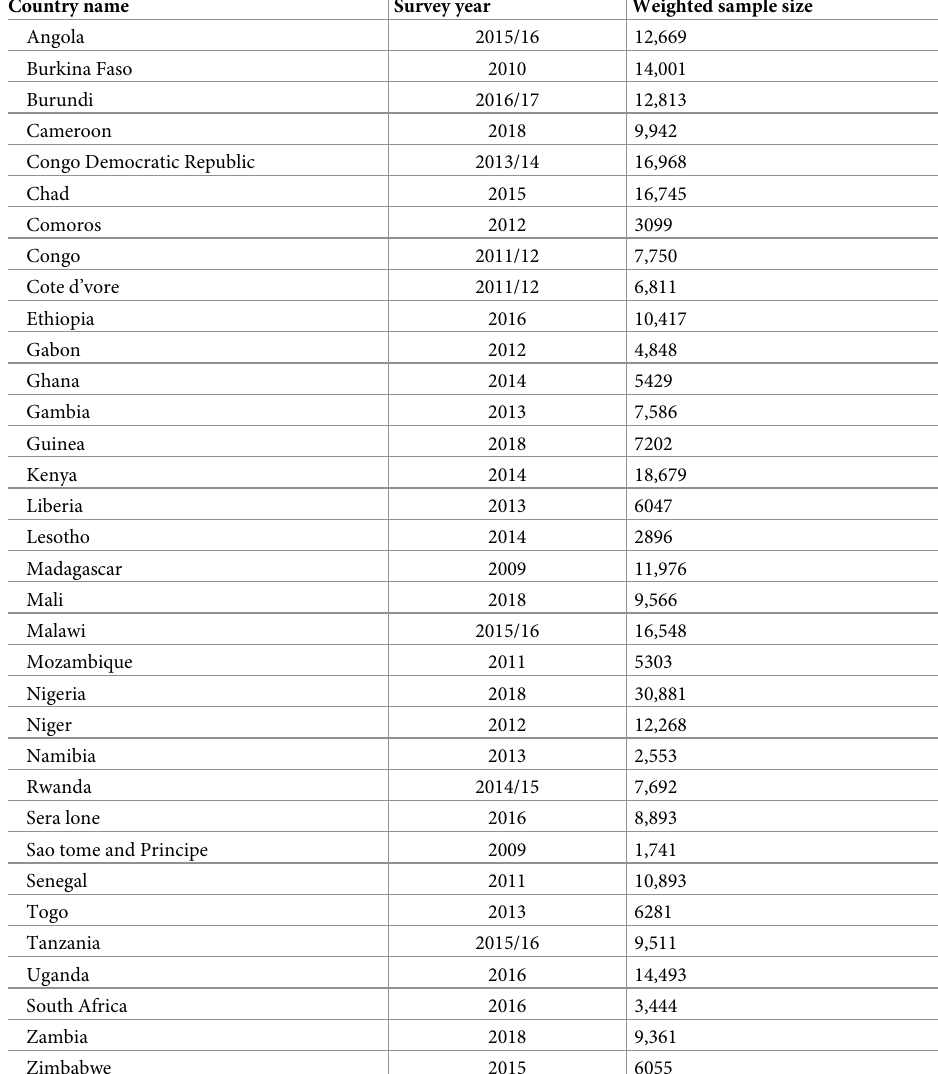
Table 1. List of sub-Saharan countries and their demographic and health survey’s